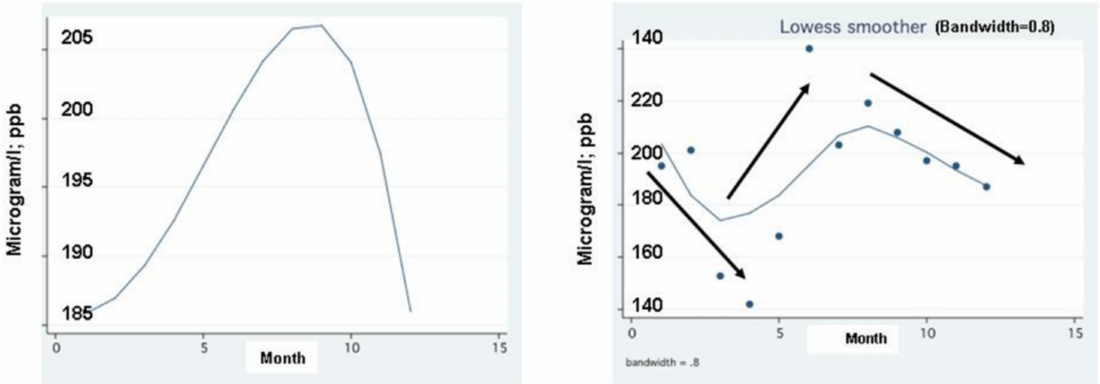
Figure 8. Monthly mean (1994–2018) fluctuations of TP concentrations (microgram/L; ppb) in the Lake Agmon outflow: Left : fractional polynomial regression. Right : LOWESS smoother plot (bandwidth = 0.8). Trends are arrowed.